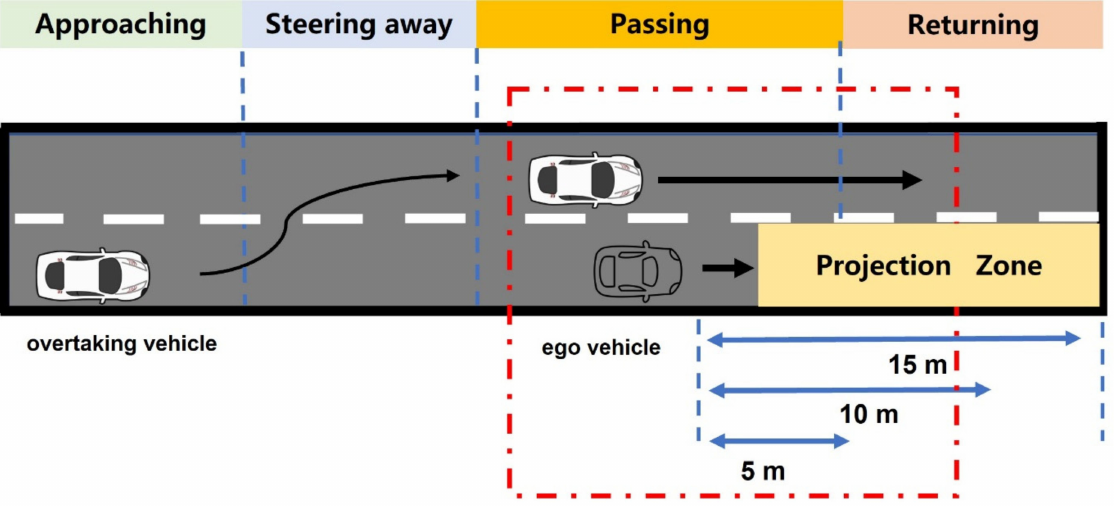
Figure 1. Overtaking scenario (the red dotted line represents the concerned time when the overtaking vehicle is in the blind-spot area of the black ego